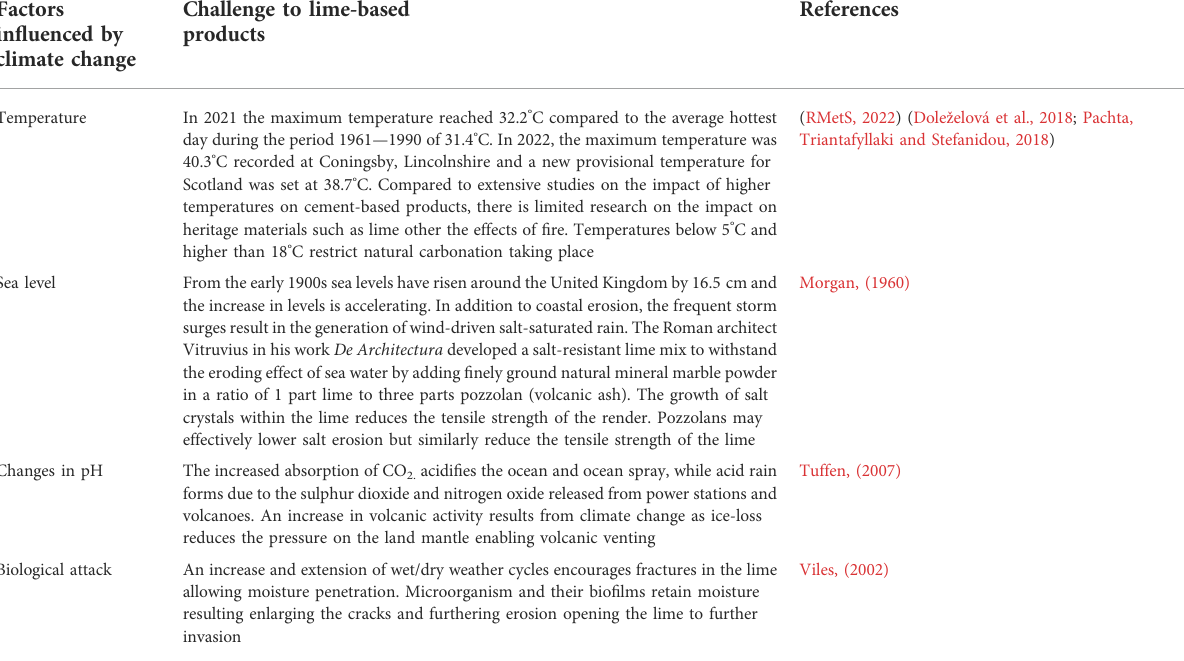
TABLE 1 Environmental factors in fl uenced by climate change and their impact on lime-based products. Factors in fl uenced